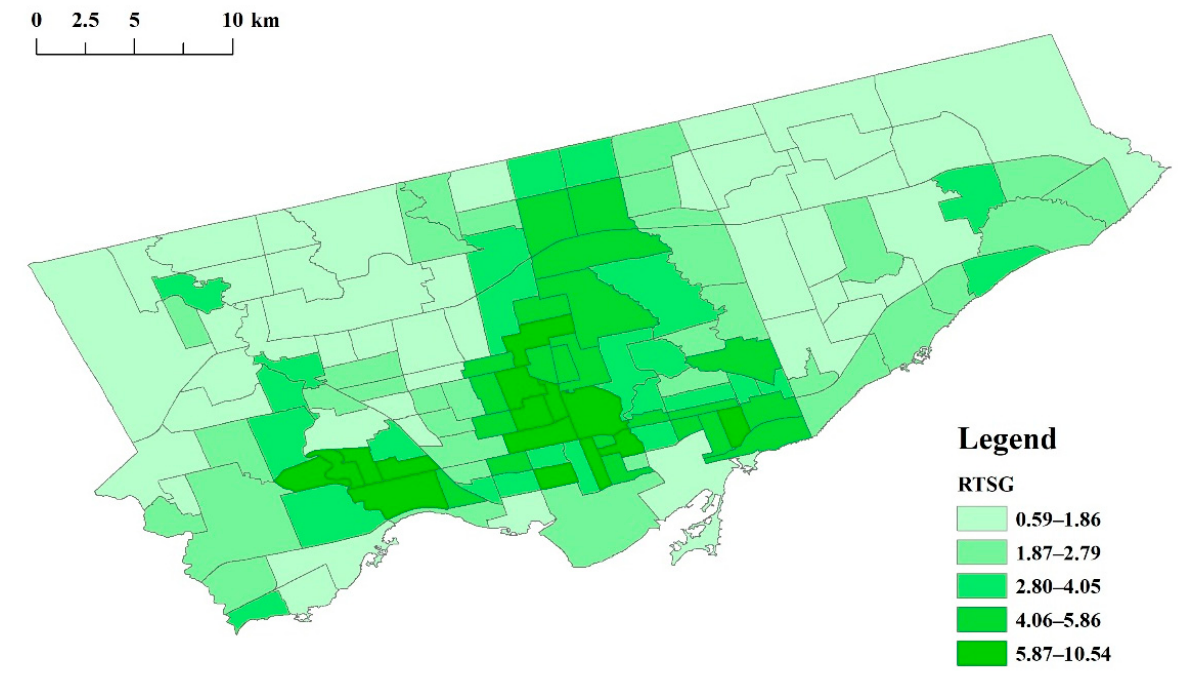
Figure A10. Distribution of the ratio of trees to shrubs–grass (RTSG).